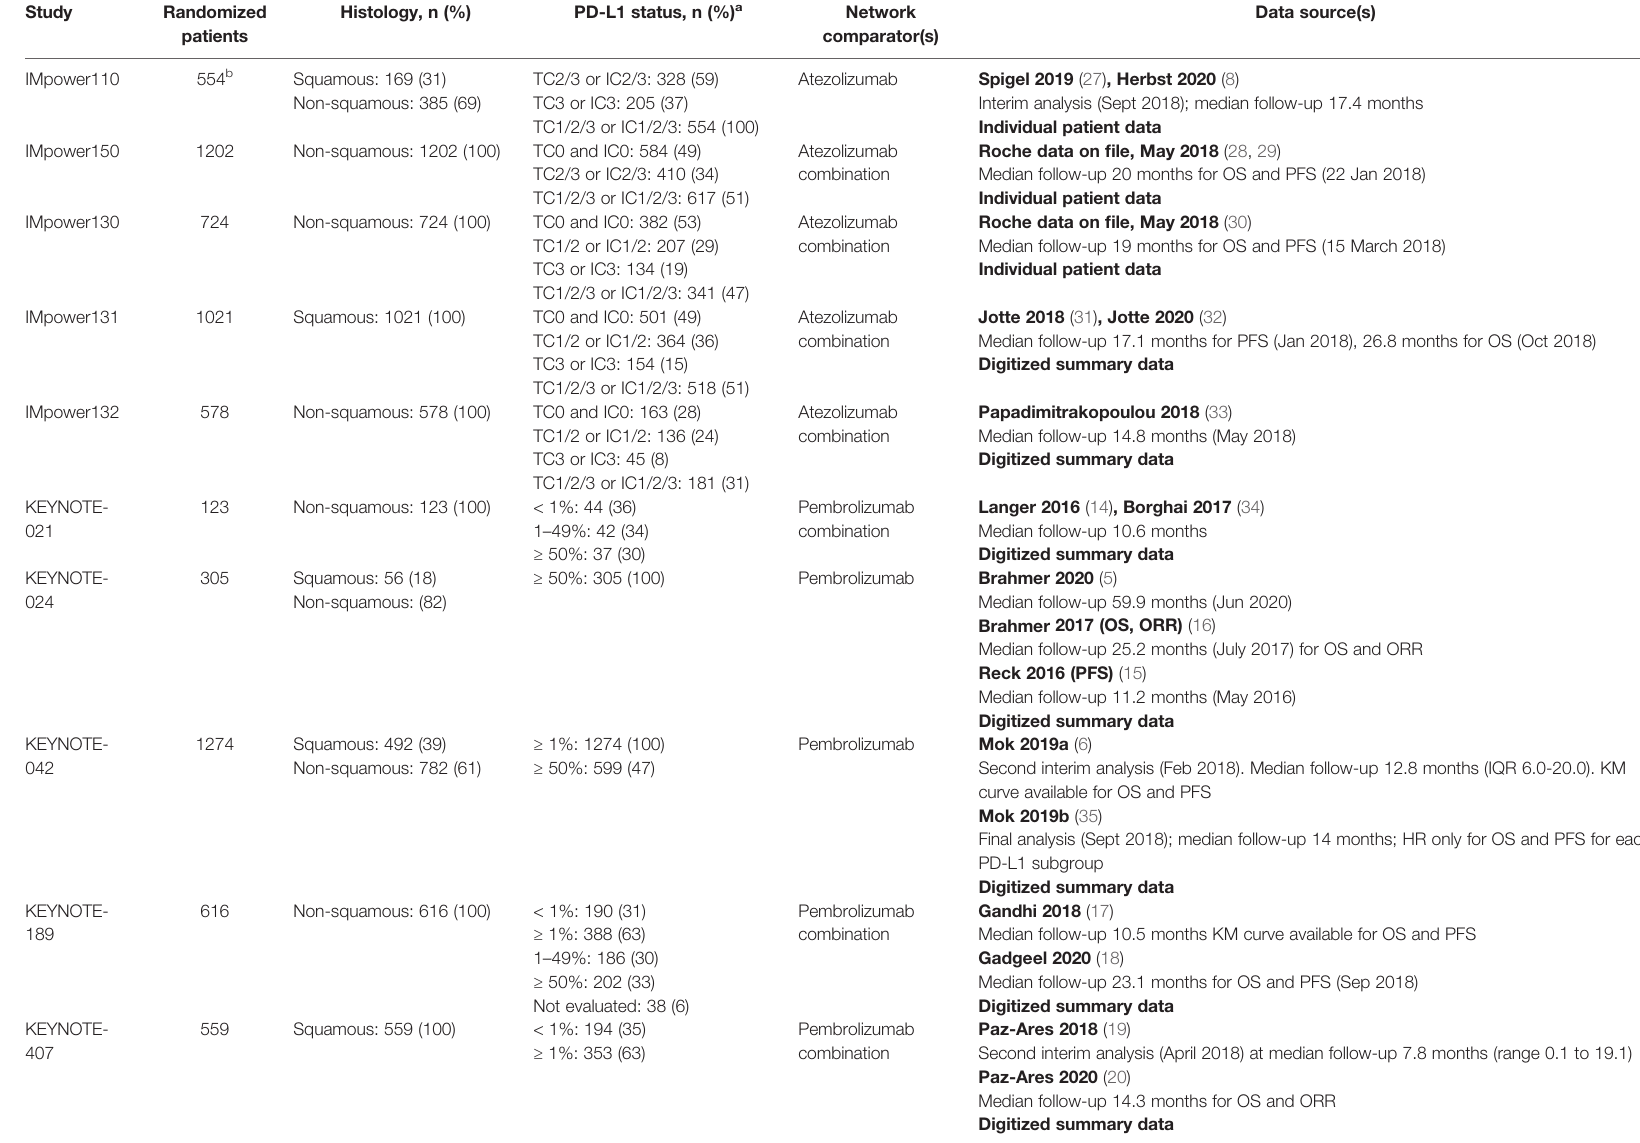
TABLE 1 | Studies and treatments in the evidence